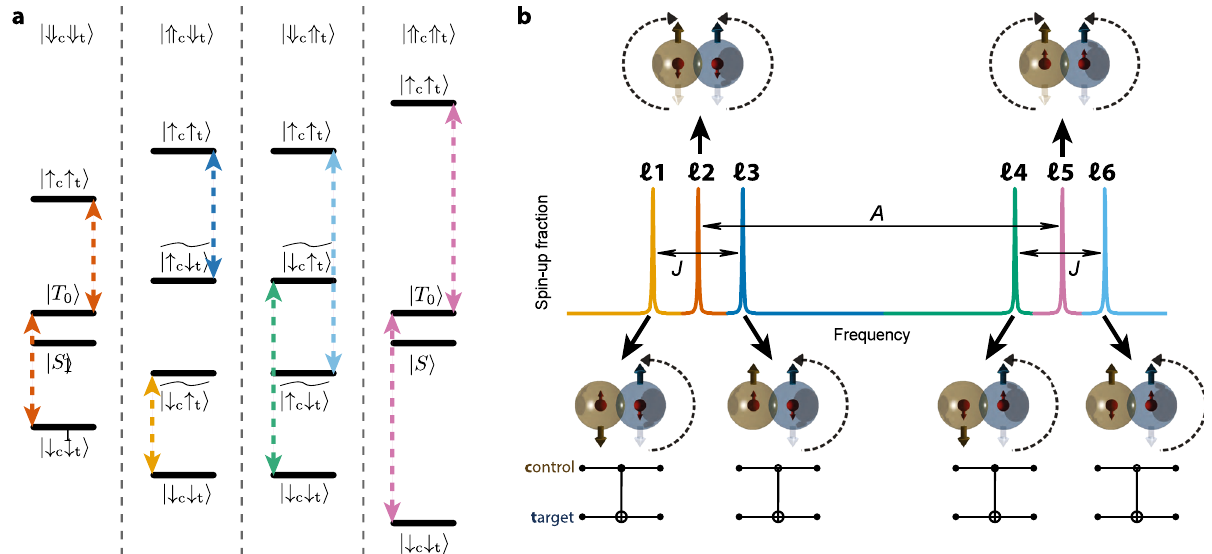
Fig. 2 Two-qubit gate operation for weakly exchange-coupled 31 P electron spin qubits. a Electronic energy level diagram of a pair of 31 P donors in the four possible nuclear spin con fi gurations; we assume here for simplicity A c = A t = A and J ≪ A . b Simpli fi ed schematic of the ESR spectrum of the target electron in the four possible nuclear spin con fi gurations, and two control electron spin orientations. The nuclear spins provide an energy detuning δϵ ≡ A , while the exchange interaction splits by J the resonance frequencies of the target qubit, depending on the state of the control qubit. At the bottom, cartoons and quantum circuit diagrams illustrate the electron spin rotations and the quantum gate operations (CROT and zero-CROT) obtainable on each of the depicted resonance (cid:1) þ in the control donor, respectively; their average is A ¼ ð A t Þ = 2 and their difference Δ A = ( A − A A t c ). c